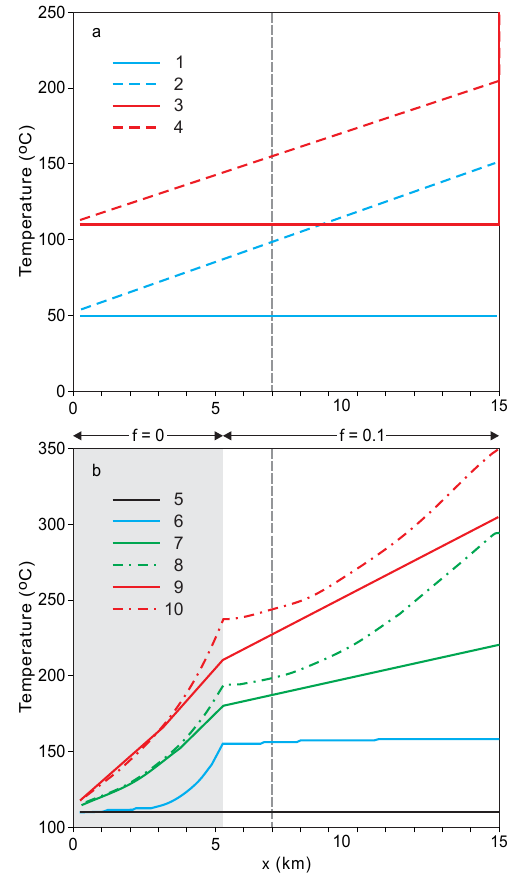
Figure A5. The effect of the intrusion advection option of HEAT3D: (a) Horizontal temperature profiles at z = 1000m (1, 2) and z = 3000m (3, 4) at the moment of magma emplacement. Solid lines – intrusion advection disabled; dashed lines – intrusion ad- vection enabled. (b) Horizontal temperature profiles at z = 3000m, capturing the consecutive events in a simulation following the sce- nario from Supplement 1: (5) conductive heat transfer; (6) water convection allowed; (7) emplacement of the pluton #1; (8) effect of water convection 50ka after pluton #1 emplacement; (9) emplace- ment of the pluton #2; and (10) effect of water convection 50ka after pluton #2 emplacement. The vertical dashed line corresponds to the x coordinate of the reference